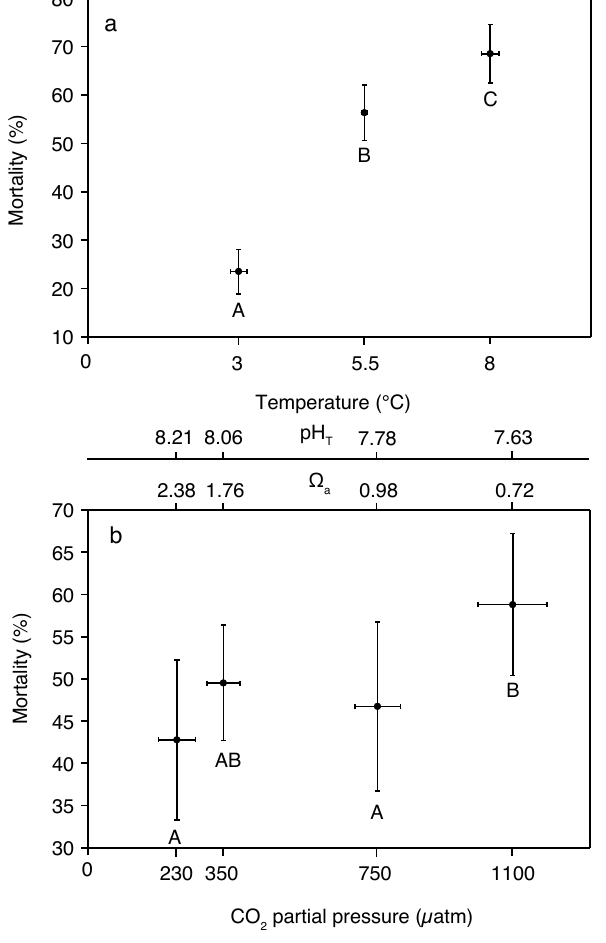
Fig. 6. Percent mortality after 29 days of incubation of Limacina helicina . Means for the effects of temperature (a) and p CO 2 (b) . Vertical bars denote 0.95 confidence intervals for mortality, hor- izontal bars denote 0.95 confidence intervals for temperature and p CO 2 , respectively. Results from the Tukey HSD post-hoc test are depicted by letters with levels not connected by same letter being significantly different.